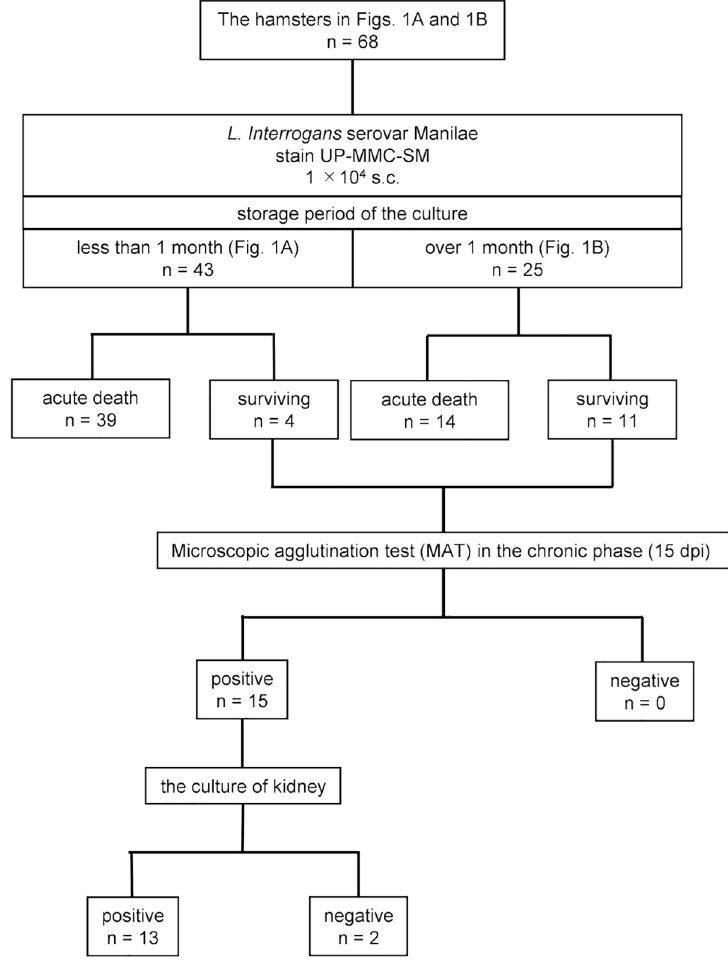
Fig 2. Microscopic agglutination test (MAT) and kidney cultures of surviving hamsters in the chronic phase. Fig 2 shows the outcomes of 43 hamsters (Fig 1A) and 25 hamsters (Fig 1B) and the results of MAT and kidney culture in those surviving